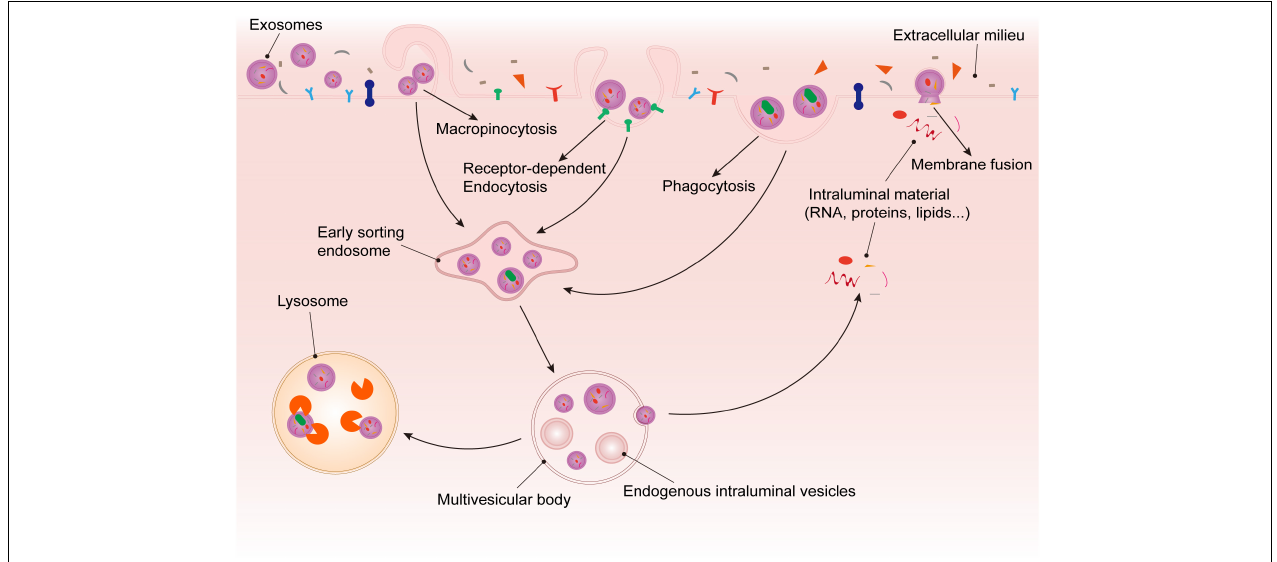
FIGURE 2 | Fate of platelet-derived exosomes in recipient cells. After being recognized by recipient cell surface receptors, exosomes enter cells through via phagocytosis, macropinocytosis, membrane fusion, or receptor dependent endocytosis. On the one hand, exosomes that enter via membrane fusion release their cargoes into the target cells directly. On the other hand, the exosomes that enter the cell via the other methods are internalized to form ESEs, and then combine with ILVs to form MVBs. Some of the exosomal substances are released from MVBs, and the rest would be degraded by